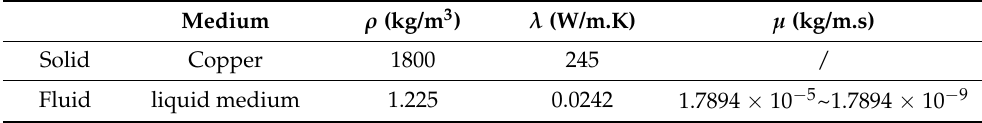
Figure 3. Grid of copper foam. Table 2. Physical property parameter.